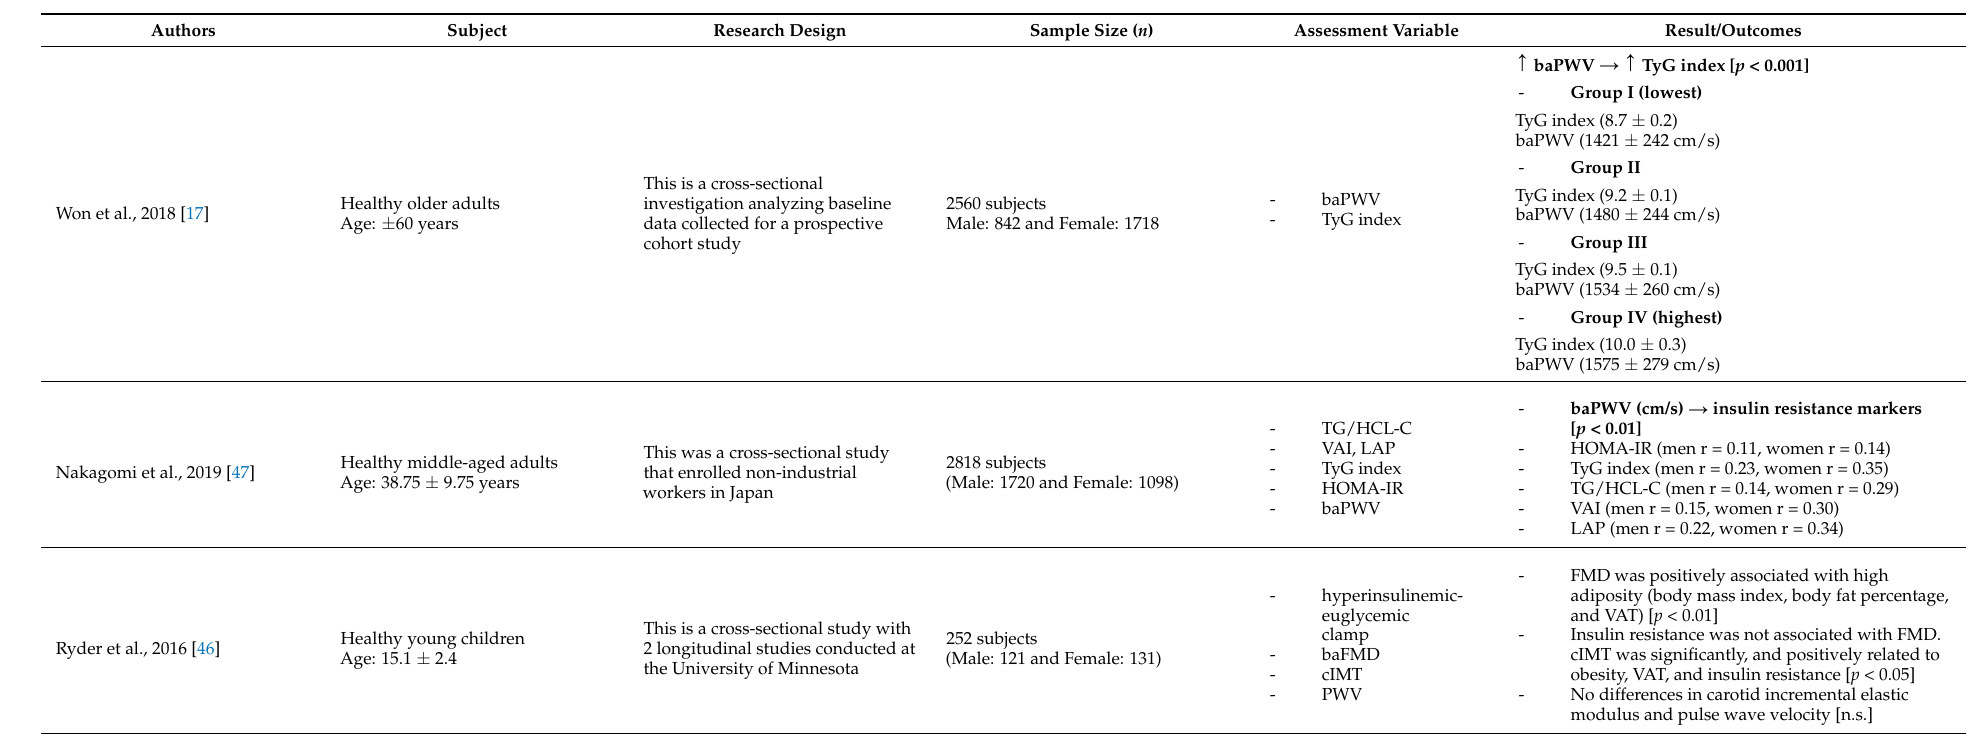
Table 1. Cont. Table 1. Summary of the associations between metabolic impairments and arterial stiffness.